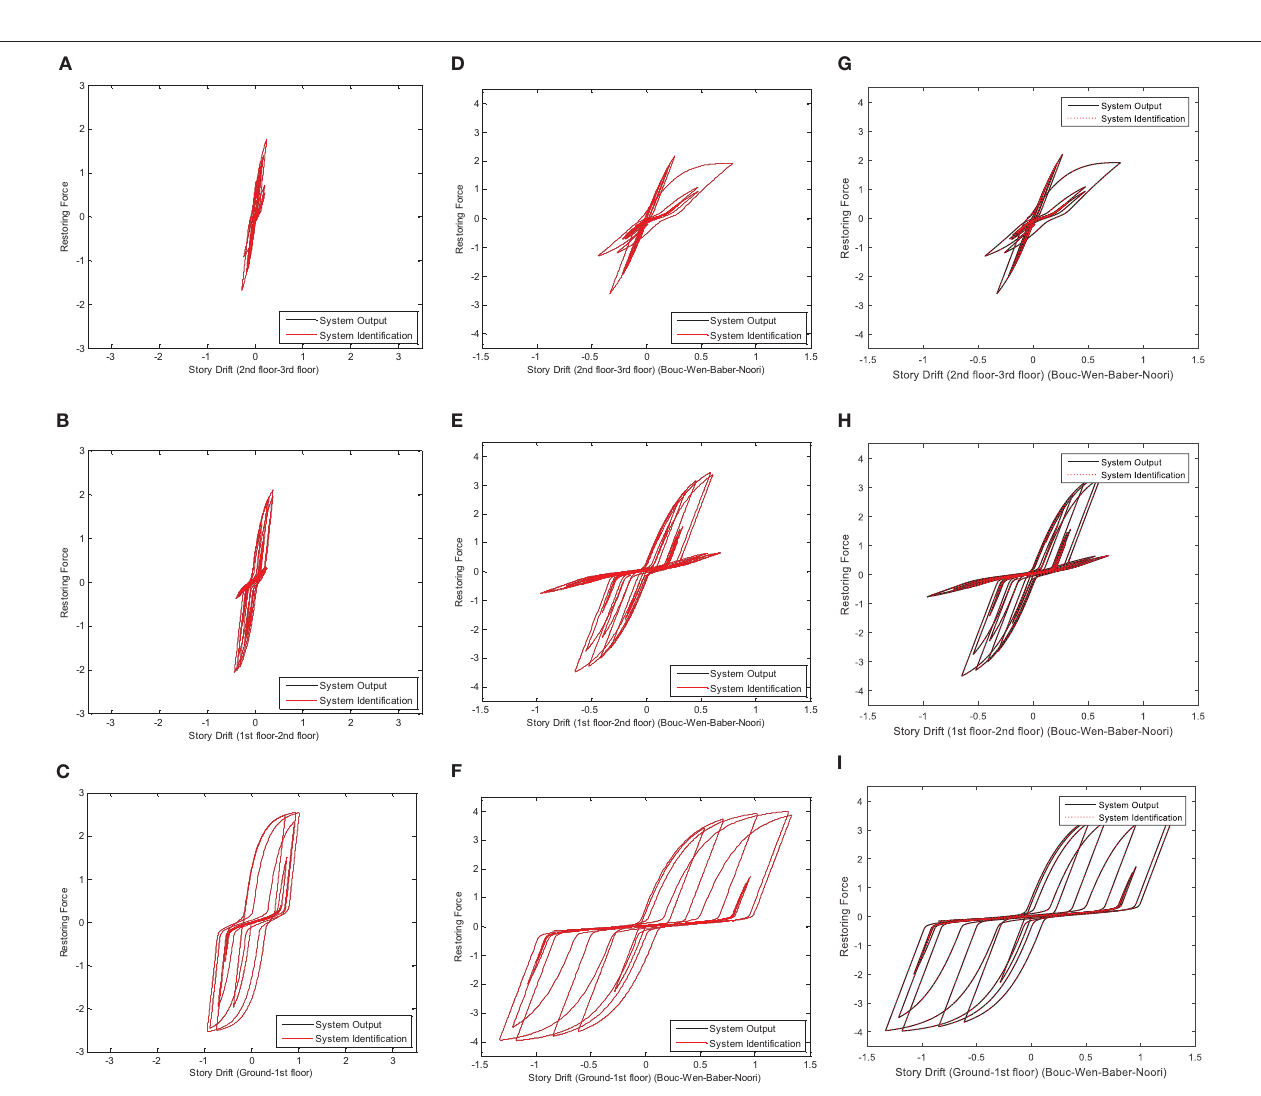
FIGURE 7 | System identification results (Sin) (A–C) IPV, (D–F) GA, (G–I) TMCMC.